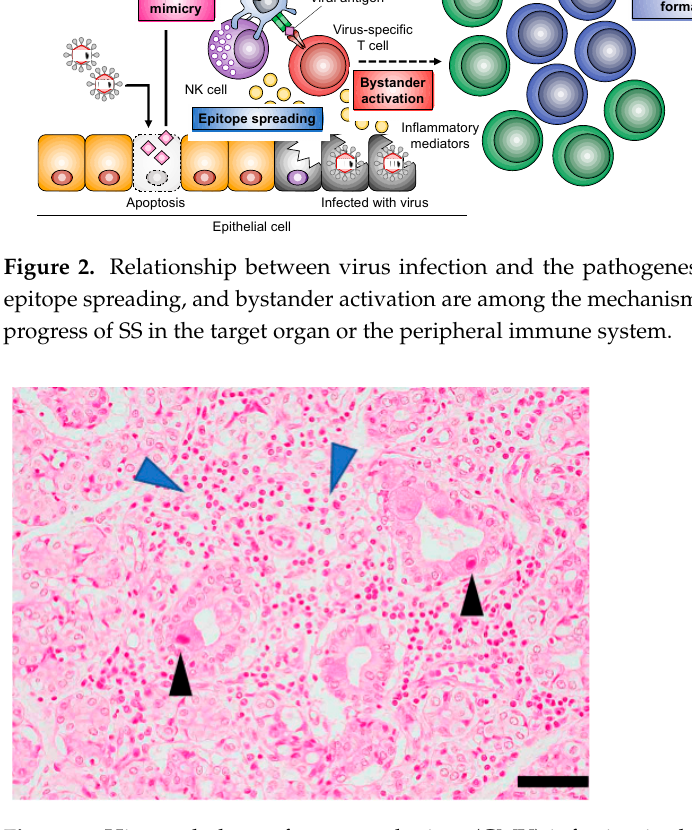
Figure 2. Relationship between virus infection and the pathogenesis of SS. Molecular mimicry, epitope spreading, and bystander activation are among the mechanisms associated with the onset or progress of SS in the target organ or the peripheral immune system.